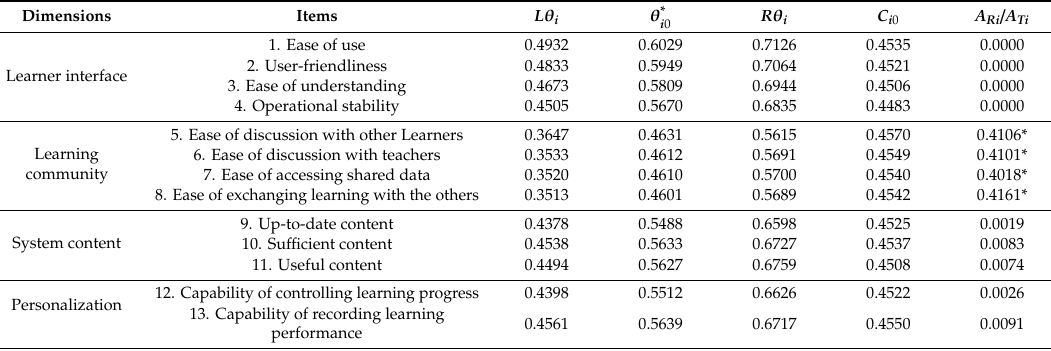
Table 1. Satisfaction Indices for CALL